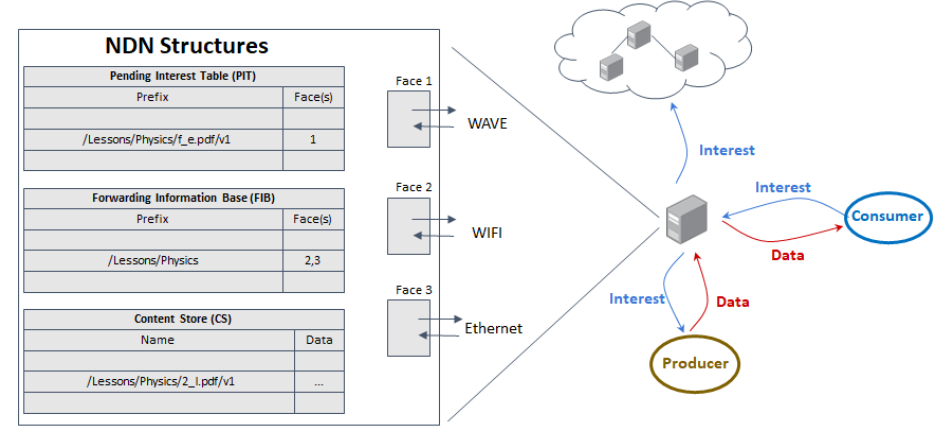
Figure 1. Packet forwarding in